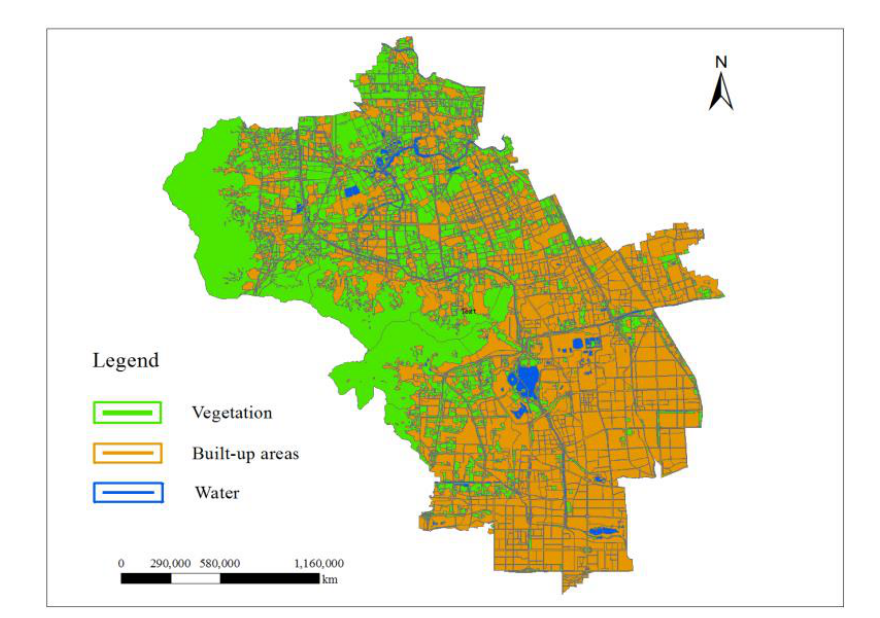
Figure 2. The corresponding interpreted product of Haidian District